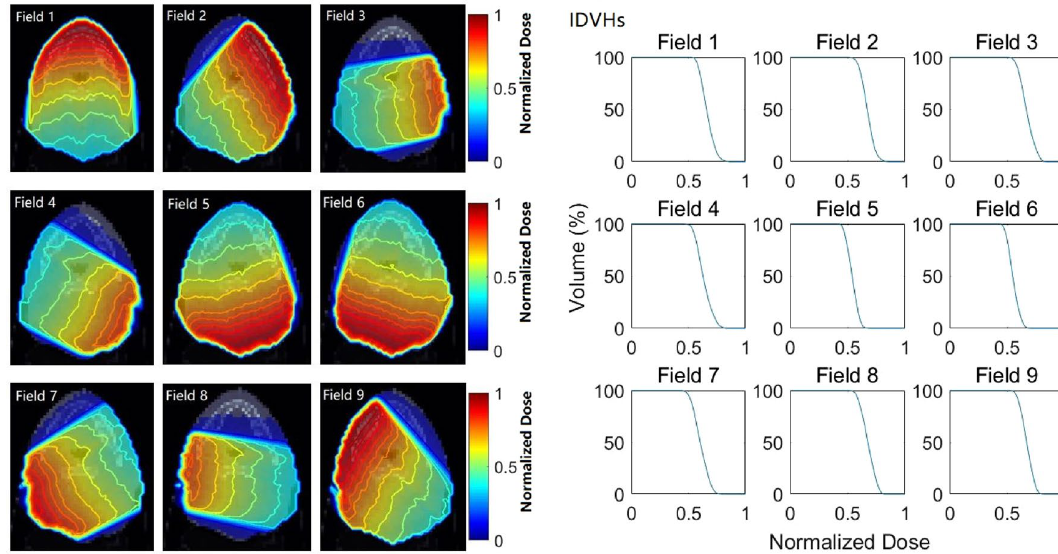
Figure 1. The dose distributions of the 9 individual fields with uniform-intensity irradiation at the same CT slice of a nasopharyngeal carcinoma patient (left) and the IDVHs of a highlighted structure